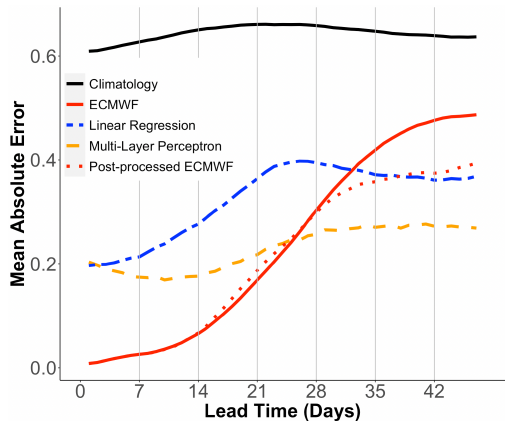
Figure 6. Mean absolute error (MAE) as a function of the lead time for the following forecasting models: climatology (solid black), ECMWF model (solid red), linear regression with sPCA output (double-dashed blue), multilayer perceptron (dashed orange), and post-processed ECMWF model (dotted